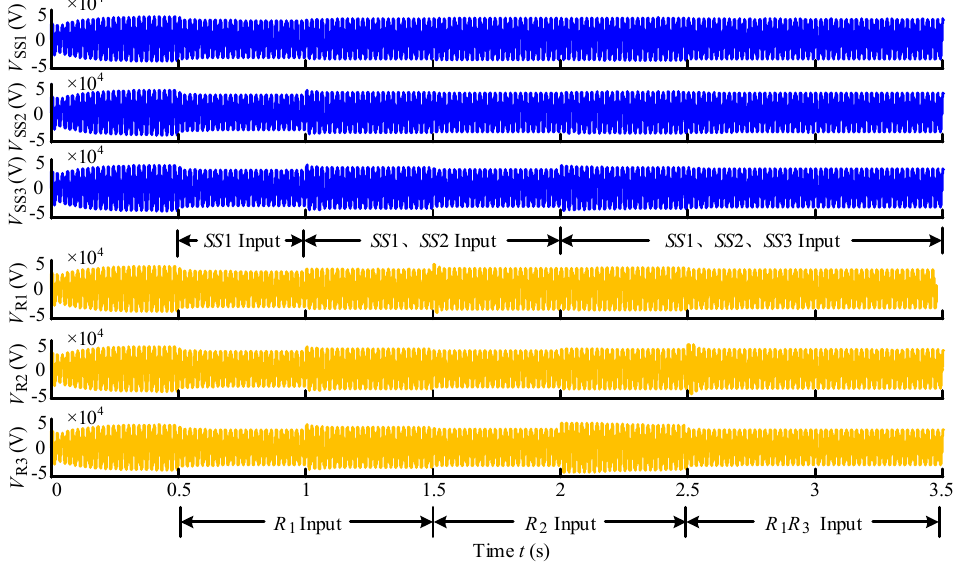
Figure 15. The voltage waves of the traction substations and the locomotives in 0 ‒ 3.5 s.